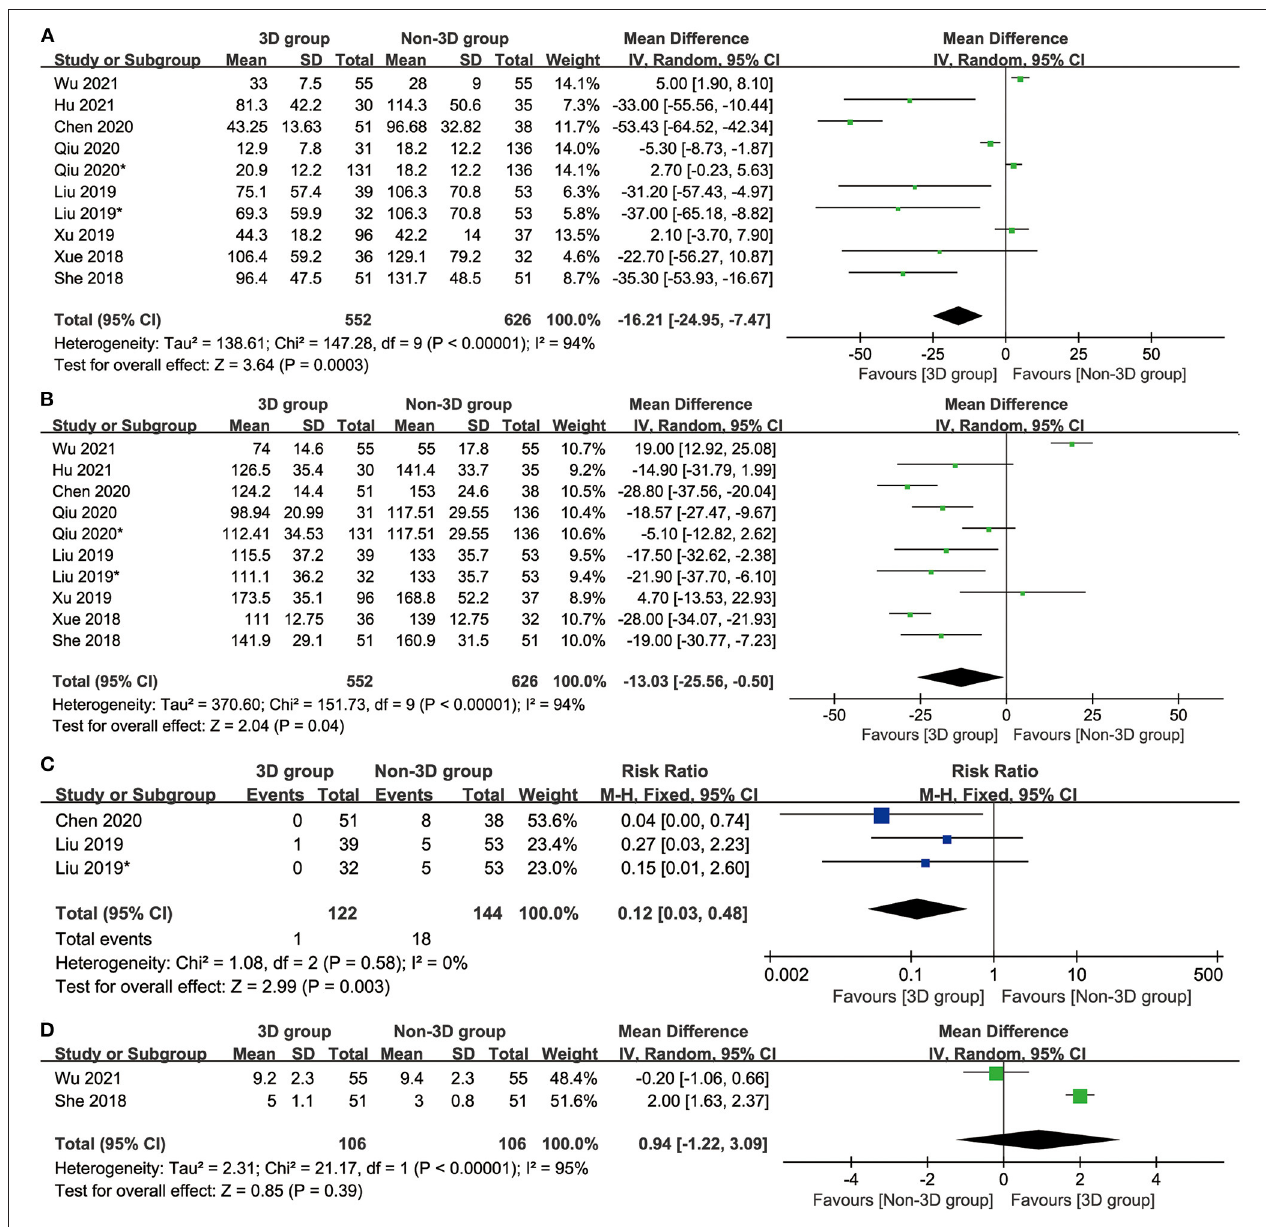
FIGURE 2 | Forest diagrams of intraoperative indicators: blood loss (A) , operative time (B) , conversion (C) , resected LNs (D) .